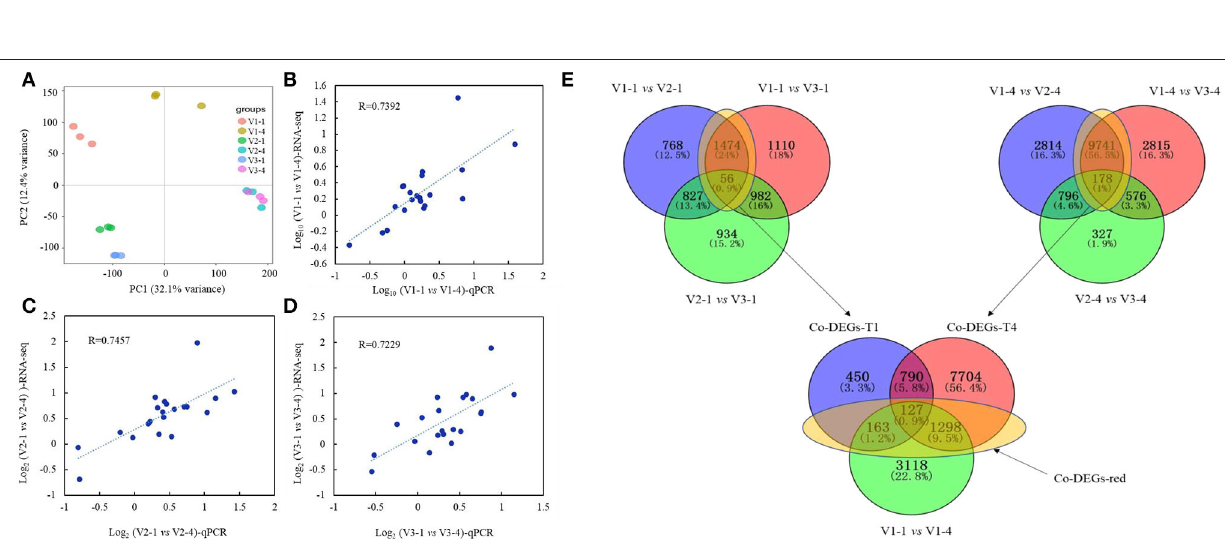
FIGURE 4 | PCA analysis, qRT-PCR validation, and Venn diagrams of RNA-seq data. (A) PCA analysis of RNA-seq data; (B–D) represent the validation and correlation analysis of RNA-seq and qRT-PCR results of 21 selected genes. (B) V1-1 vs. V1-4; C, V2-1 vs. V2-4; D, V3-1 vs. V3-4. (E) Venn diagram of common differentially expressed genes (co-DEGs) between V1, V2, and V3 at stage 1 and stage 4. Co-DEGs-T1 represents the genes that are co-differentially expressed in V1 vs. V2 and V1 vs. V3 at stage 1. Co-DEGs-T4 represents the genes that are co-differentially expressed in V1 vs. V2 and V1 vs. V3 at stage 4. Co-DEGs-red represents the genes that were considered key genes that are functioning in red color